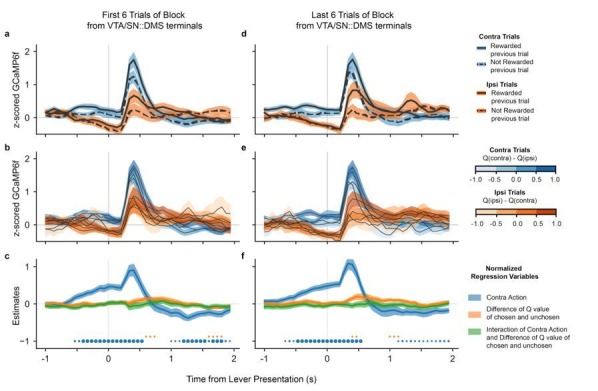
Early and late trials in block are both modulated by chosen value and contralateral action (VTA/SN::DMS Terminals, n = 12 sites)(A) GCaMP6f signal from VTA/SN::DMS Terminal (n = 12 sites) from first 6 trials of each block. Traces are time-locked to the lever presentation for contralateral trials (blue) and ipsilateral trials (orange), as well as rewarded (solid) and non-rewarded previous trial (dotted). Colored fringes represent 1 standard error from activity averaged across recording sites (n = 12) (B) GCaMP6f signal for contralateral trials (blue) and ipsilateral trials (orange), and further binned by the difference in Q values for chosen and unchosen action. Colored fringes represent 1 standard error from activity averaged across recording sites (n = 12). (C) Mixed effect model regression on each datapoint from 3 seconds of GCaMP6f traces. Explanatory variables include the action of the mice (blue), the difference in Q values for chosen vs. unchosen actions (orange), their interaction (green), and an intercept. Colored fringes represent 1 standard error from estimates. Dots at bottom mark timepoints when the corresponding effect is significantly different from zero at p<.05 (small dot), p<.01 (medium dot), p<.001 (large dot). P values were corrected with Benjamini Hochberg procedure. (D-F) Same as (A-E), except using the last 6 trials of each block.